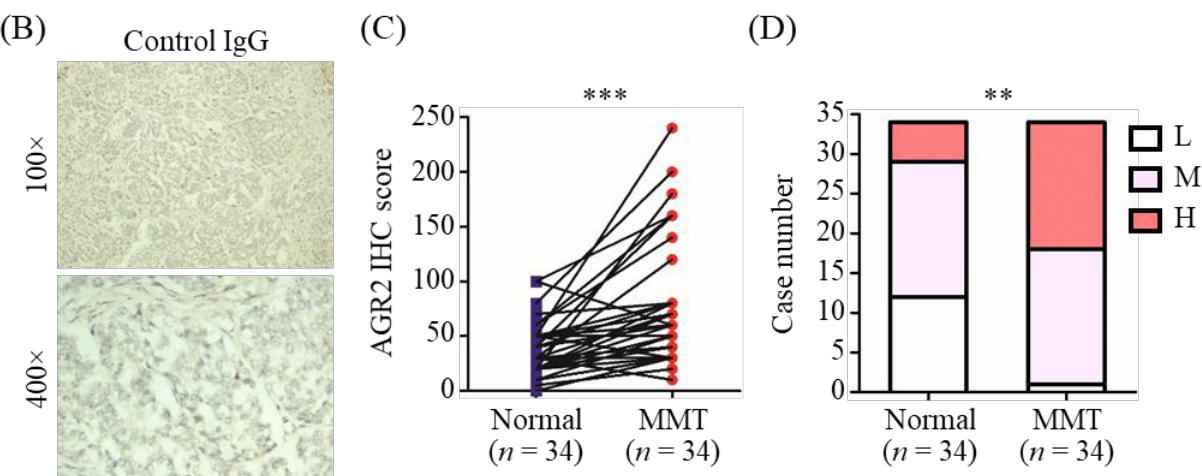
Figure 1. AGR2 overexpression in canine MMT tissues revealed by immunohistochemistry (IHC). AGR2 protein expression was analyzed with tissue slides of 34 canine MMT cases using an antibody specific to AGR2. ( A ) Micrographs of two representative cases. Upper micrographs were acquired at 100× magnification; bottom micrographs were the areas in the upper images acquired at 400× magnification. ( B ) MMT tissues stained with an isotype control IgG. ( C ) Pairwise comparison of IHC scores of AGR2 between MMT tissue and adjacent normal mammary gland tissue of the same patient. Each line represents an individual patient. Statistical significance was determined by two-tailed paired t -test. ( D ) Comparison of IHC scores of AGR2 between overall MMT tissues and adjacent normal mammary tissues. L, M, and H denote low, moderate, and high levels of AGR2, respectively. Statistical significance was determined by Fisher’s exact test. ** p < 0.01; *** p < 0.001.